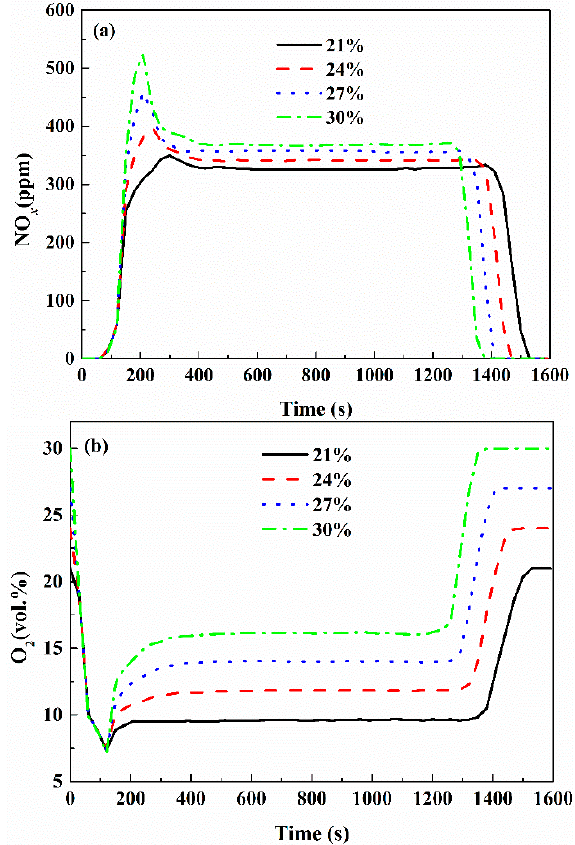
Figure 12. NO x emissions ( a ) and flue gas O 2 content ( b ) with different oxygen concentrations of air.